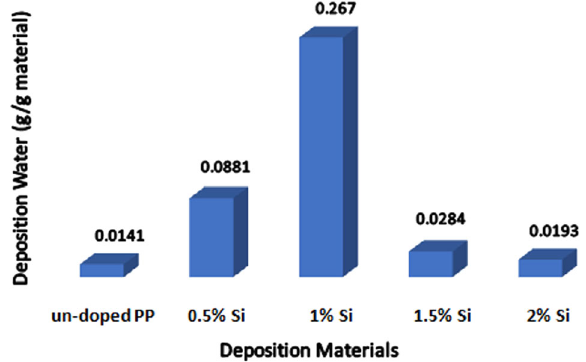
Fig. 6 The amount of collected water according to fog harvesting materials. The amount of water increased up to 0.267 g/g-material/ cm 2 with 1% fumed silica doping, whereas this value decreased to the amount of the undoped polypropylene with 2% fumed silica doping.